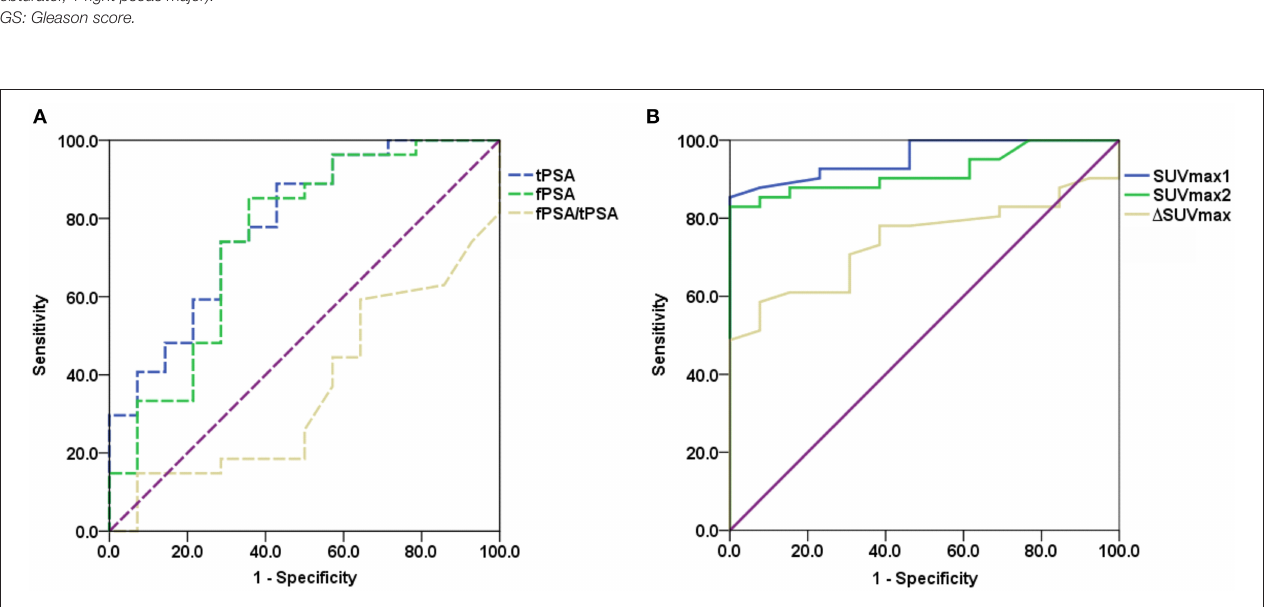
TABLE 3 | Diagnostic performance of several indices and its combination.